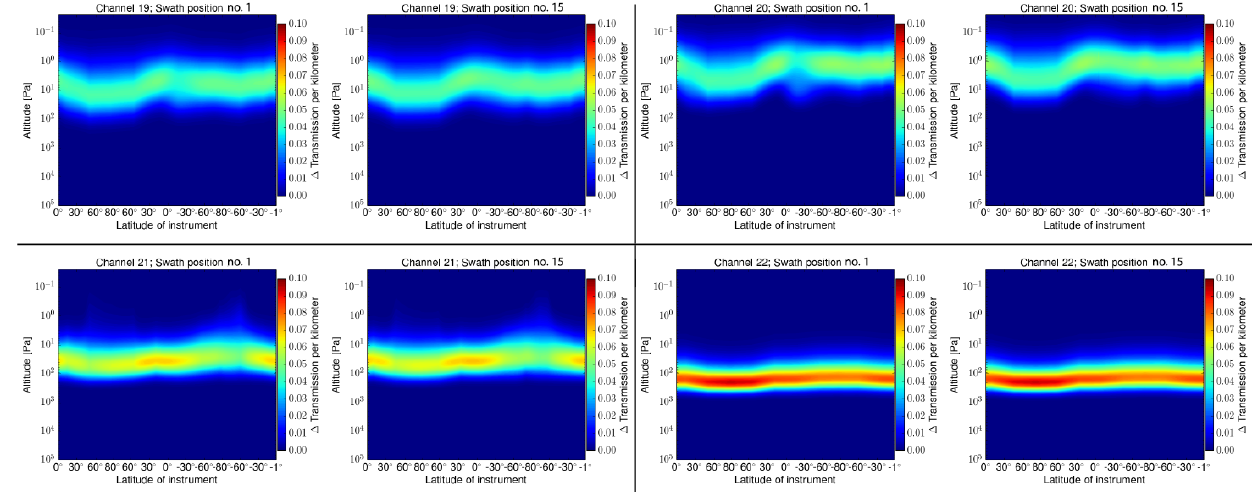
Figure 5. Weighting functions for SSMIS from ARTS with a three-dimensional magnetic field for an example of one orbit for channels 19 to 22. Color shows the change in transmissions per kilometer of atmospheric altitude traversed by the radiation. The y axis is the altitude range and the x axis shows the latitude of the sensor as a function of time. For all four channels, two swath positions are shown. Position no. 15 points downward along the orbit of the sensor. Position no. 1 points westward as the sensor travels northward, and it points eastward as the sensor travels